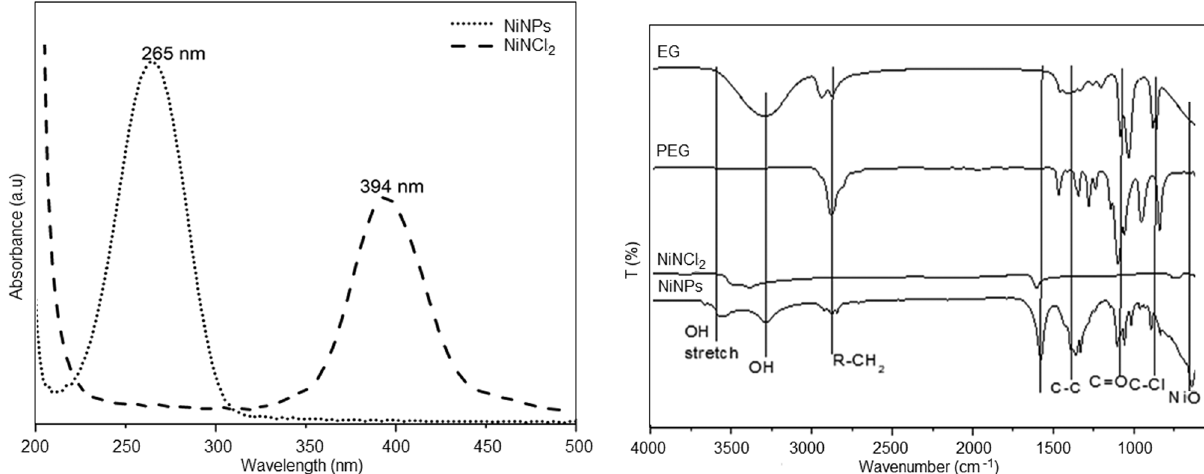
Figure 6: Overlay of the λ max SPR of NiNPs and bulk nickel solution. Figure 7: FT - IR spectra of EG, PEG, NiCl 2 , and